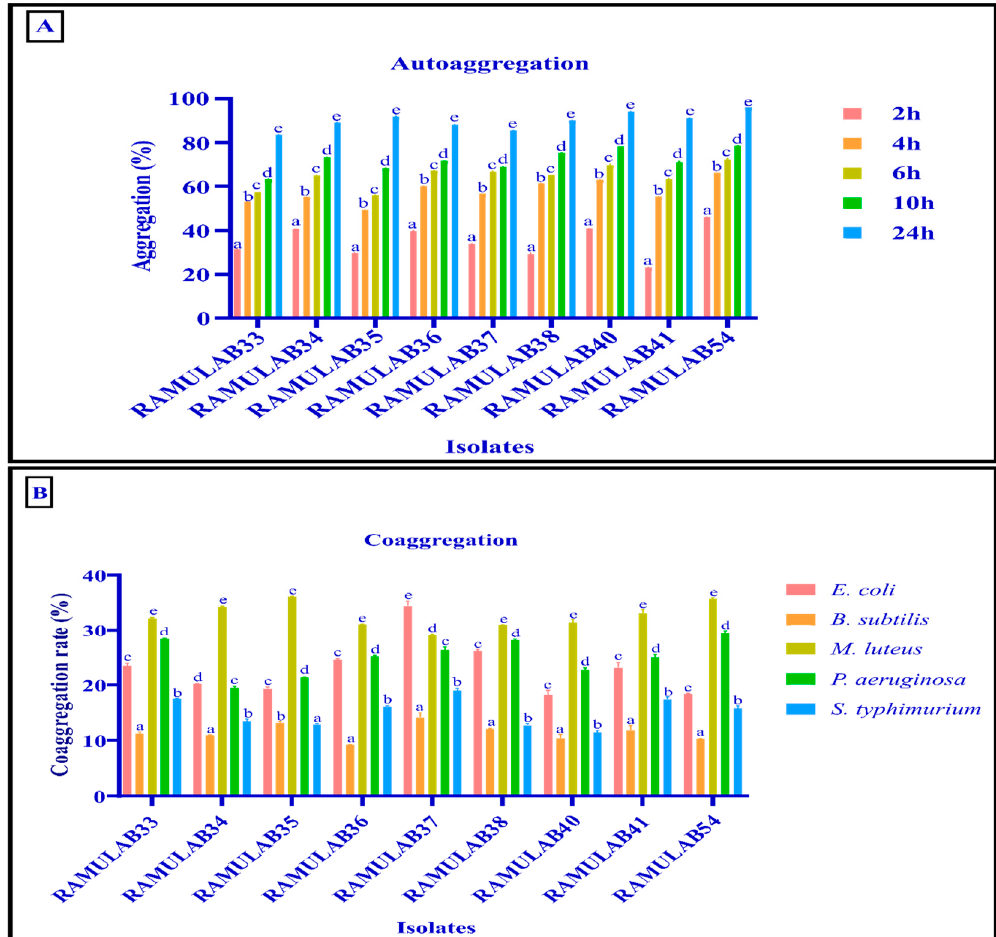
Figure 2. ( A ) The percentage of strains that autoaggregate over time at room temperature; ( B ) the percentage of LAB strains that coaggregate after two hours at room temperature. The mean ± SD is used to express data. According to the Duncan multiple range tests, the means in aggregation for 2 h with the superscripts (a–e) are signi fi cantly di ff erent ( p ≤ 0.05).